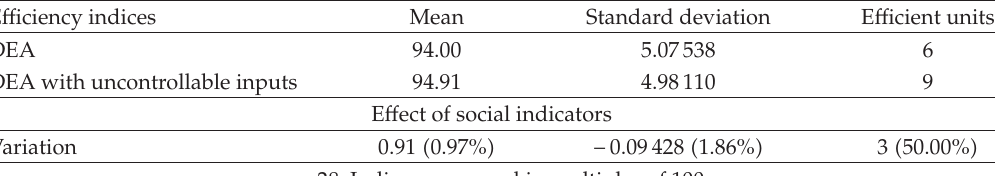
Table 6: Comparison of DEA-BCC input-oriented models: e ff ect of social